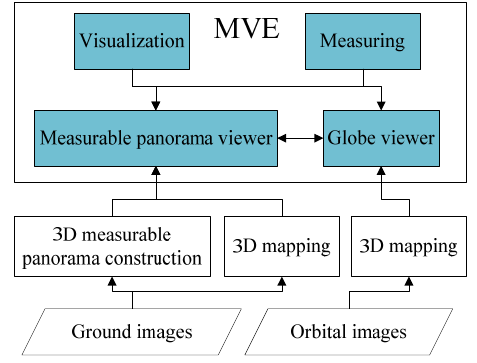
Figure 1. Conceptual diagram of MVE